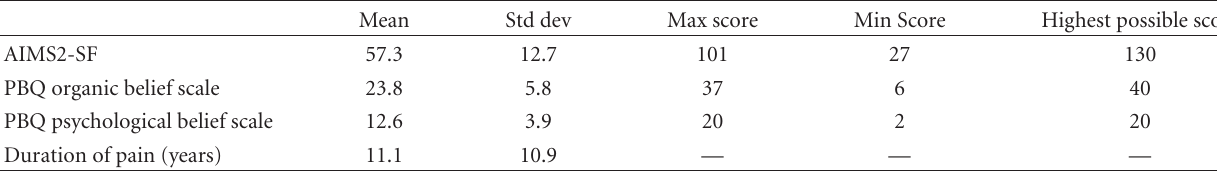
Table 4: Data for primary hypothesis testing.